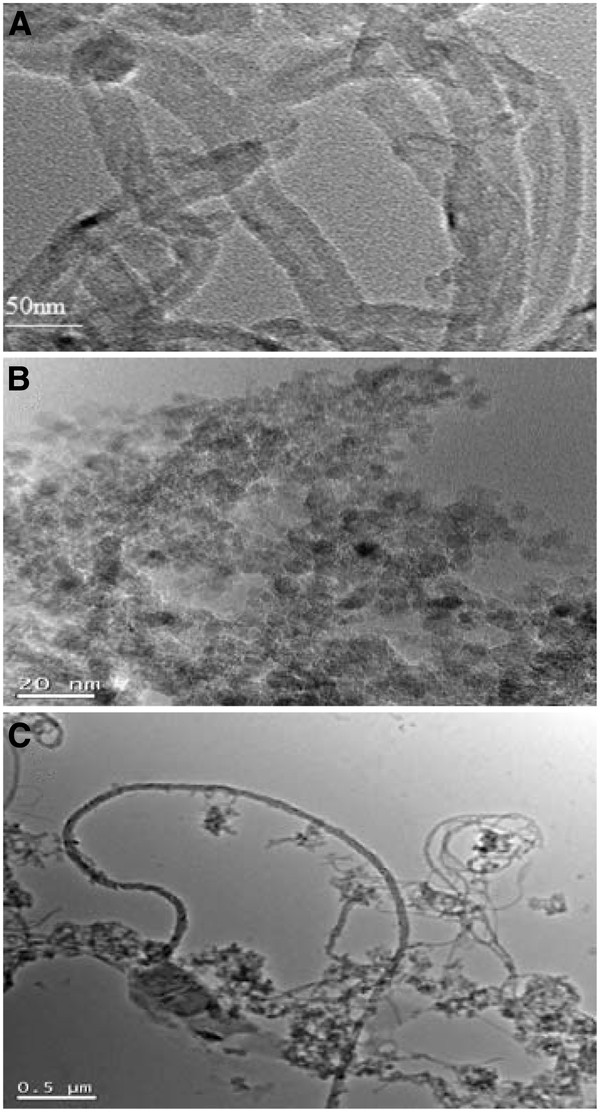
TEM images of oMWCNTs (A), NDs (B), and oMWCNTs + NDs (C). oMWCNTs and NDs were suspended in water before the TEM grids were prepared.